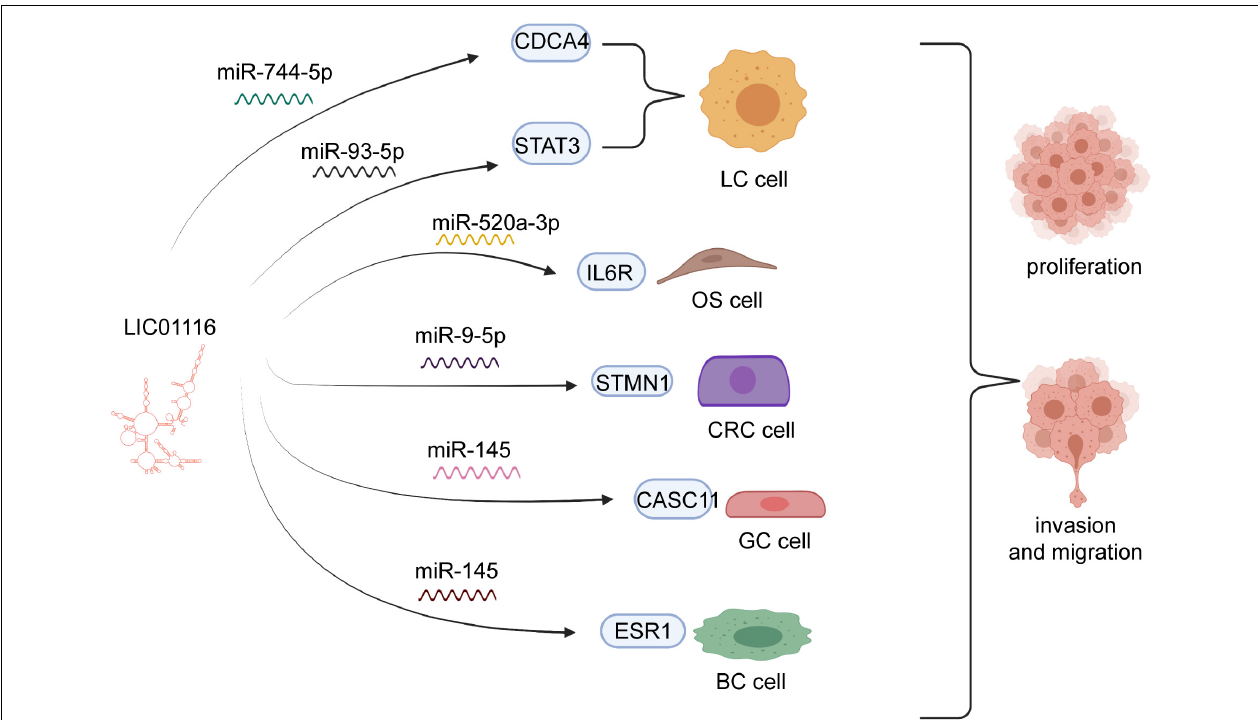
FIGURE 2 | Diagram of the biological mechanisms involved in LINC01116 association with tumors. LINC01116 exerts an effect on the cell proliferation, invasion, and migration of multiple cancers, through sponging of miRNAs to mediate target regulators, such as miR-744-5p, miR-93-5p, miR-520a-3p, miR-9-5p, and miR-145.